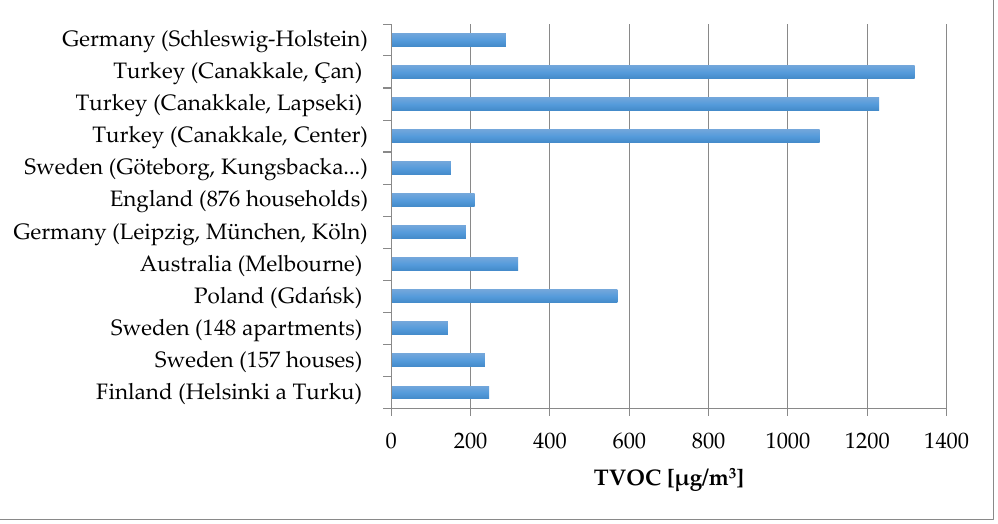
Figure 1. Overview of TVOC levels in homes across the different studies [28–32].